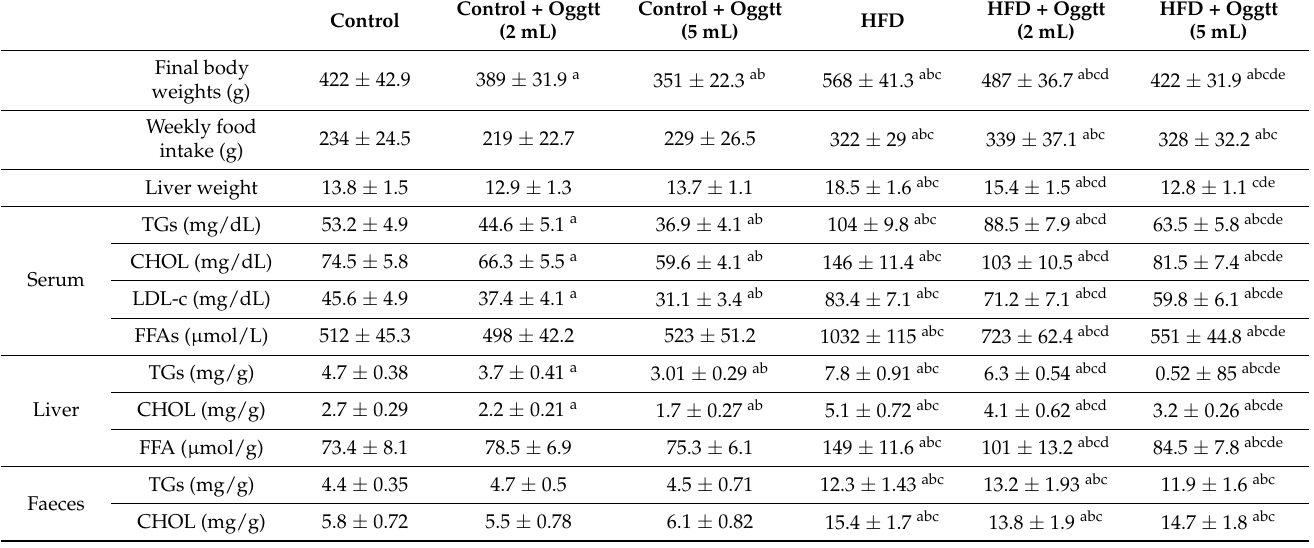
Table 1. Oggtt suppresses the gain in body weight and attenuates hyperlipidaemia and hepatic lipid accumulation in rats fed the control and the high-fat diet (HFD) in a dose-dependent manner. Control + Oggtt Control + Oggtt HFD + Oggtt HFD + Oggtt Control HFD (2 mL) (5 mL) (2 mL) (5